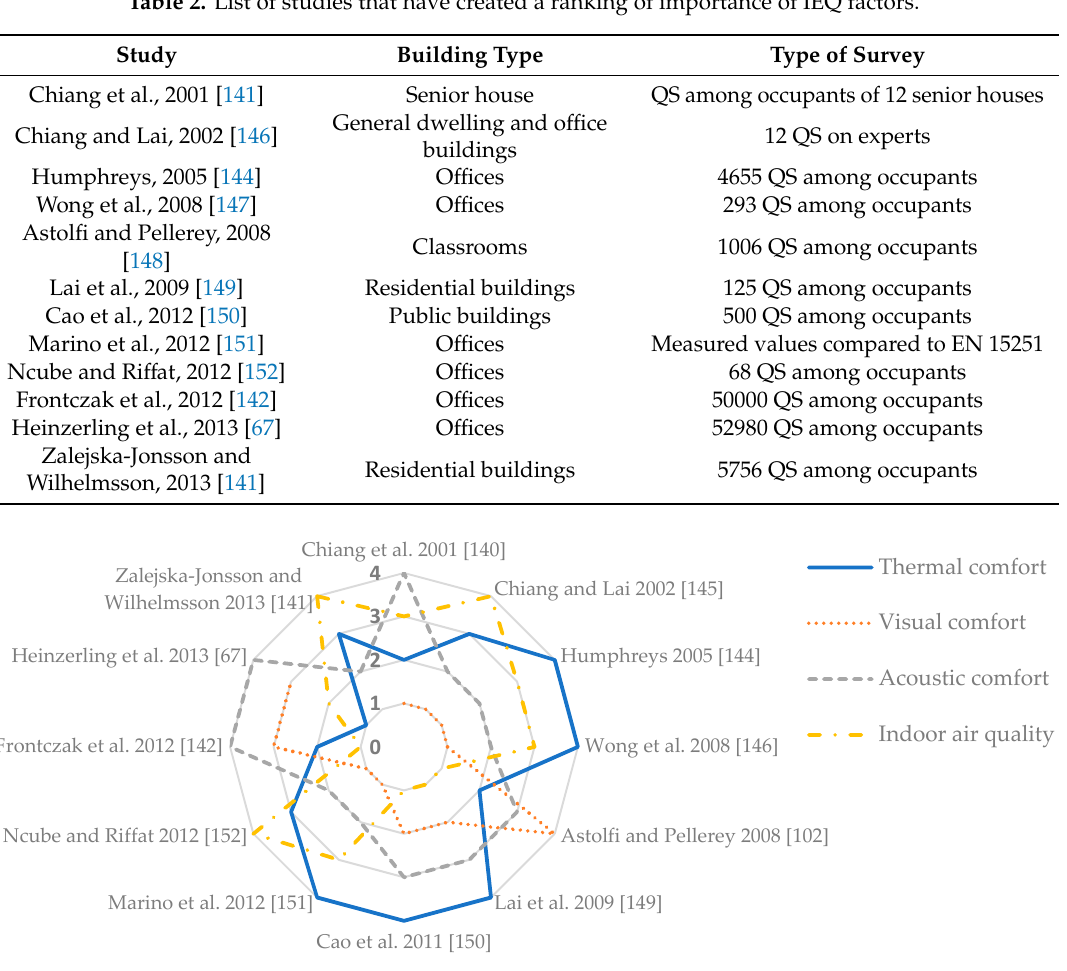
Figure 5. Ranking according to the importance of individual IEQ factors and their contribution towards overall satisfaction with the IEQ. The higher the number, the higher the importance.